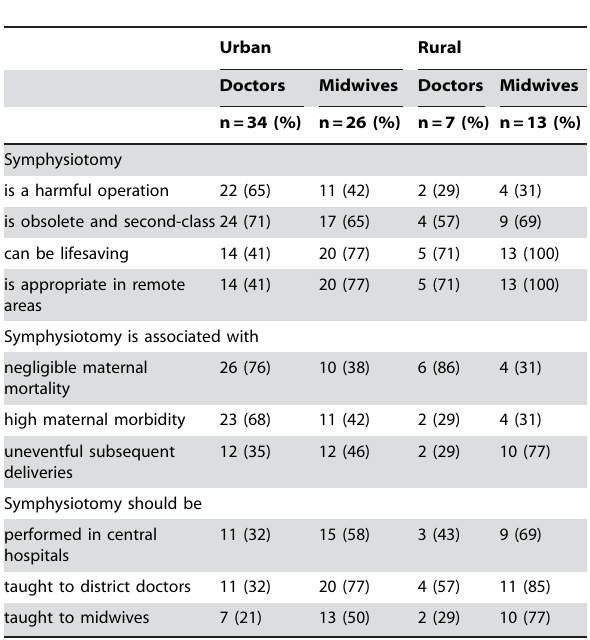
Table 6. Affirmative answers on statements about symphysiotomy among doctors and midwives in three hospitals in the two largest cities of Zimbabwe (Harare and Bulawayo), and among doctors and midwives at seven district